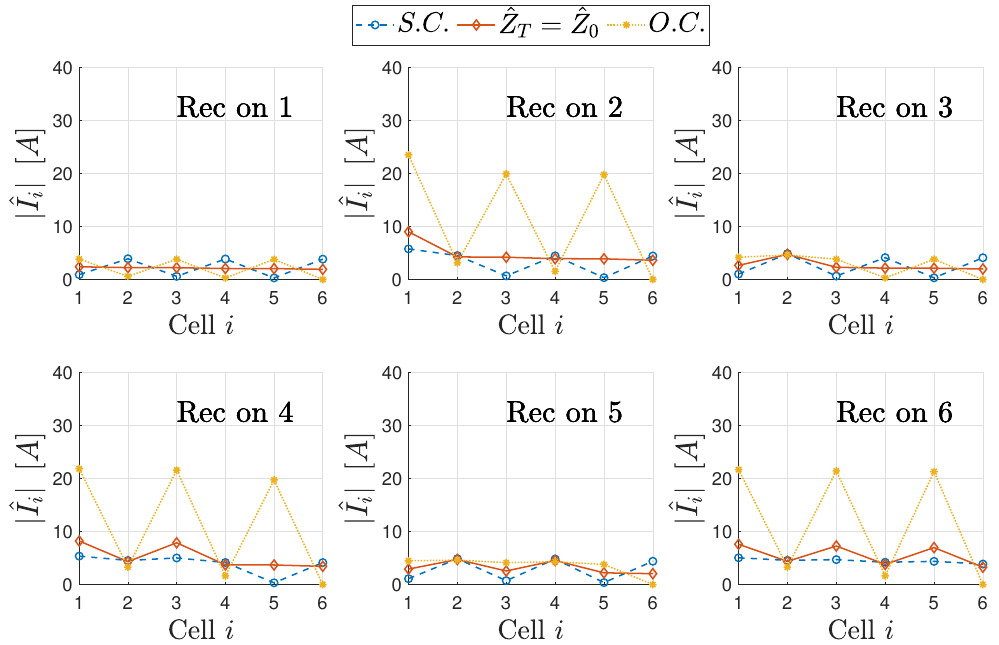
Figure 19. Standing wave patterns for different positions of the receiver, different terminations and a receiver load ˆ Z load = 15 Ω